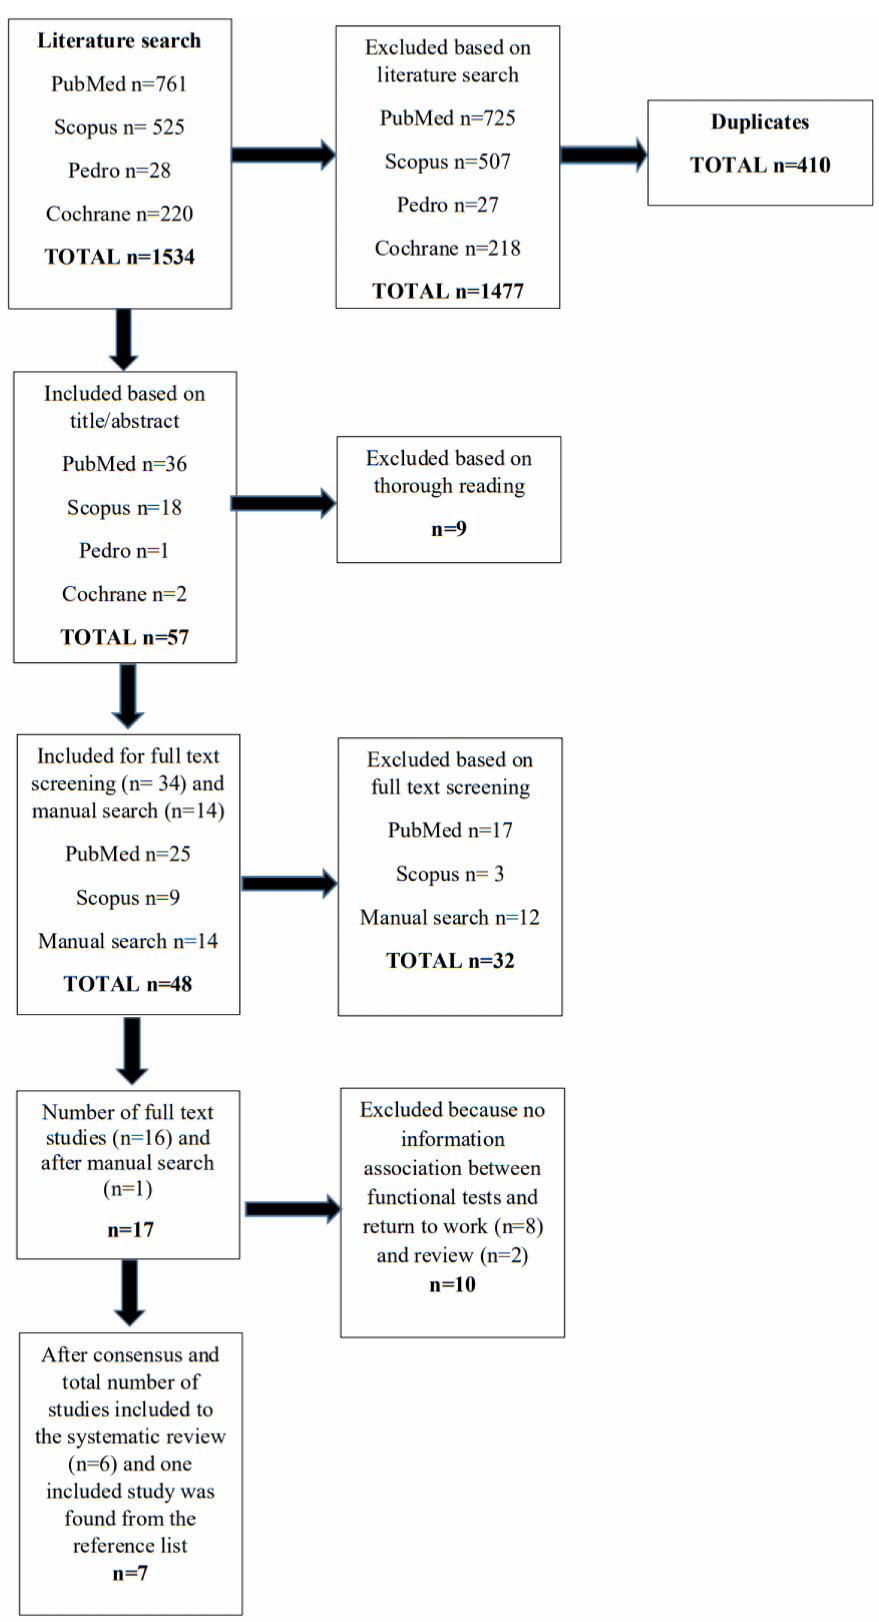
Figure 1. Flowchart of the search